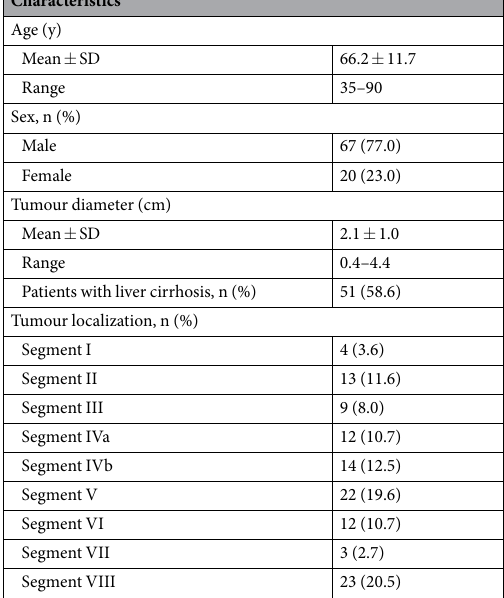
Table 1. Baseline patient and disease characteristics. SD = standard